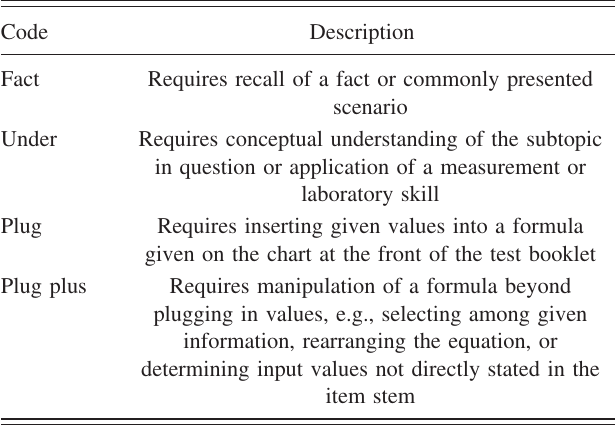
TABLE II. Codes resulting from the primary round of open coding for the knowledge or skills needed to answer physics and physical science items on the